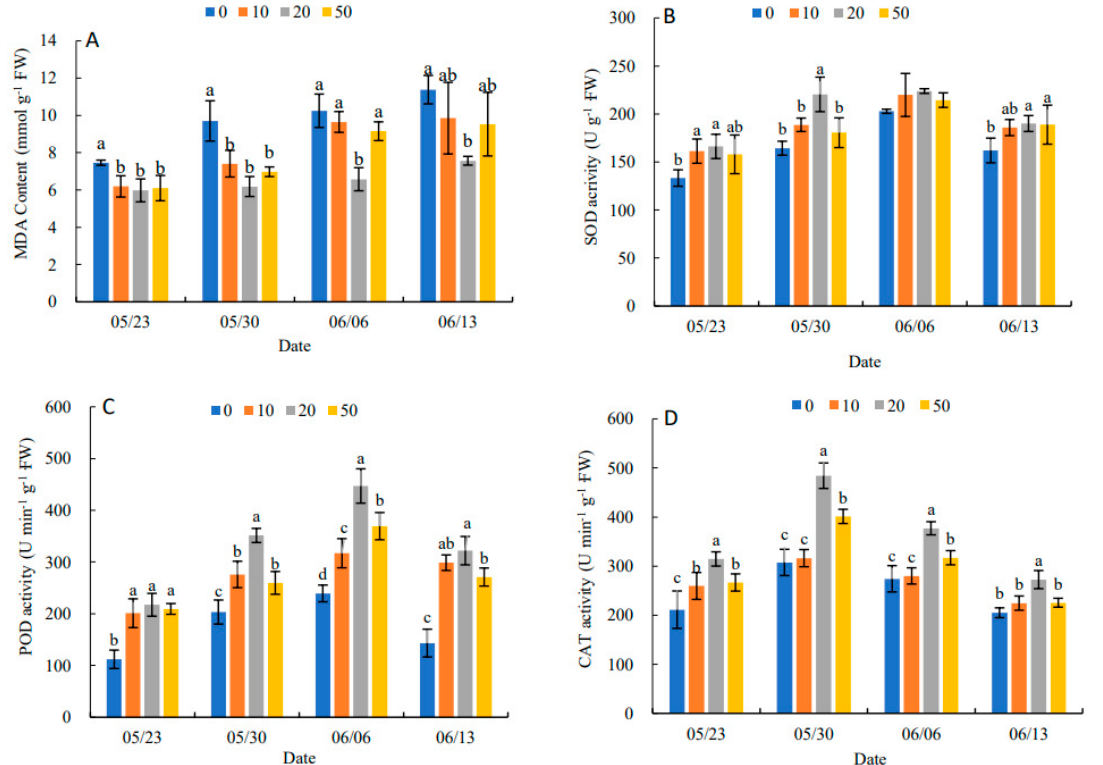
Figure 1. Effect of different concentrations of ALA on MDA content ( A ), SOD activity ( B ), POD activity ( C ) and CAT activity ( D ) of P. heterophylla leaves from 23 May to 13 June. Data show the mean with standard deviation bar of three replicates from samples. Different letters indicate a significant difference at 0.05 level between different